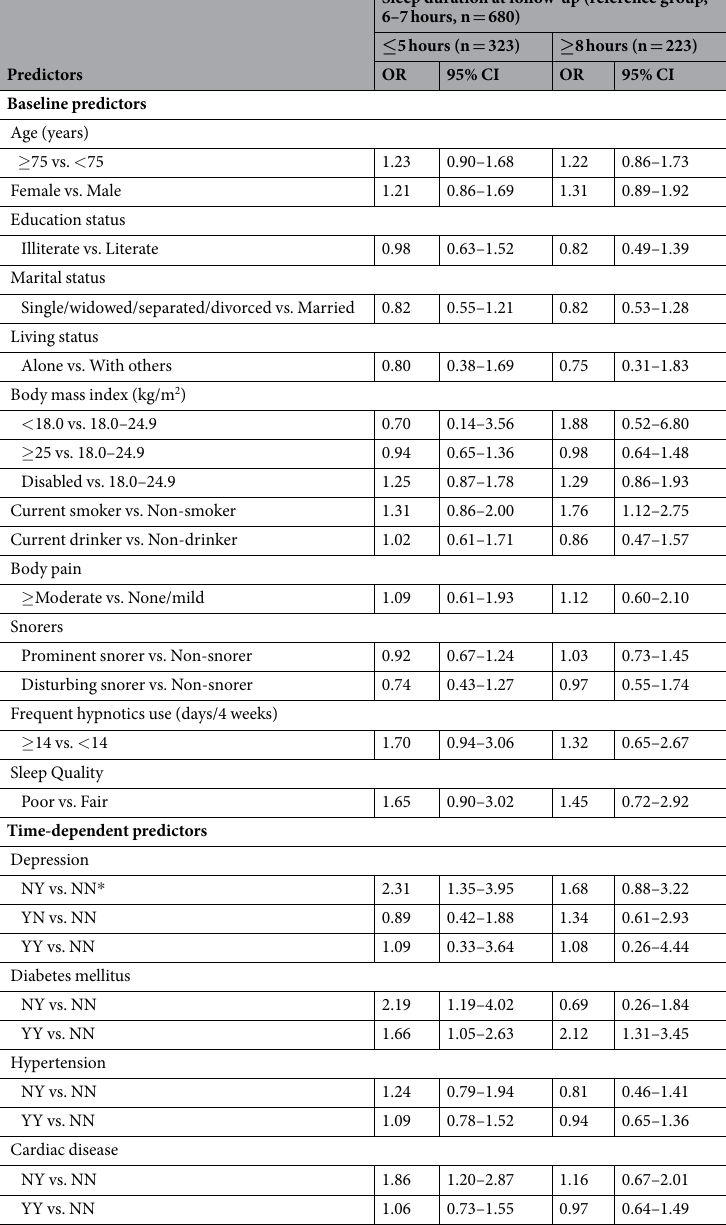
Table 2. Multinomial logistic regression for factors predicting change of sleep duration among mid-range sleepers at baseline (n = 1226). * NN: absent for both baseline and follow-up survey; NY: incident condition during the follow-up period; YN: present in the baseline but remitted during follow-up; YY: present in the